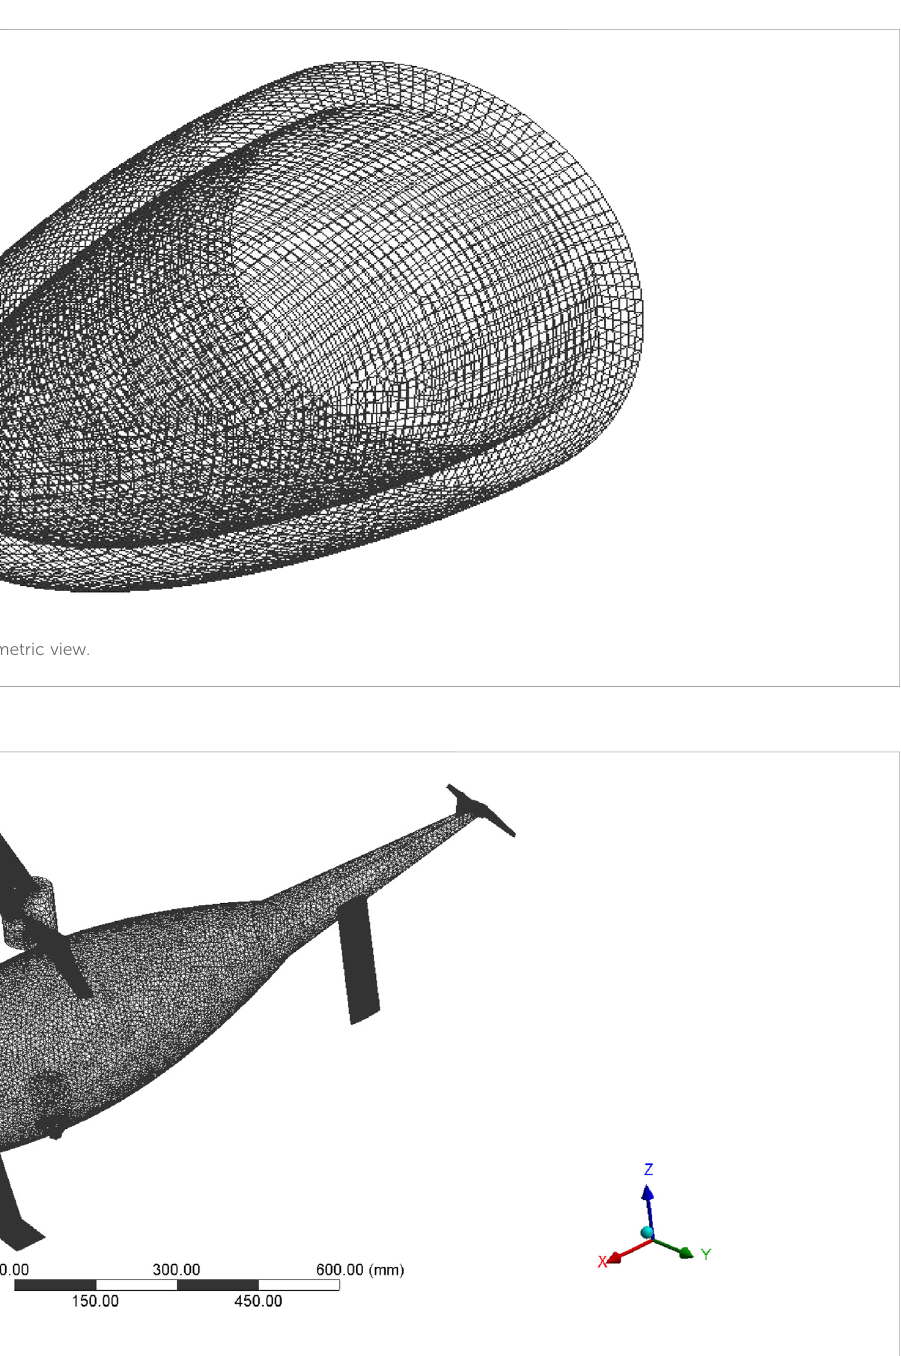
A typical isometric representation of discretized structure of